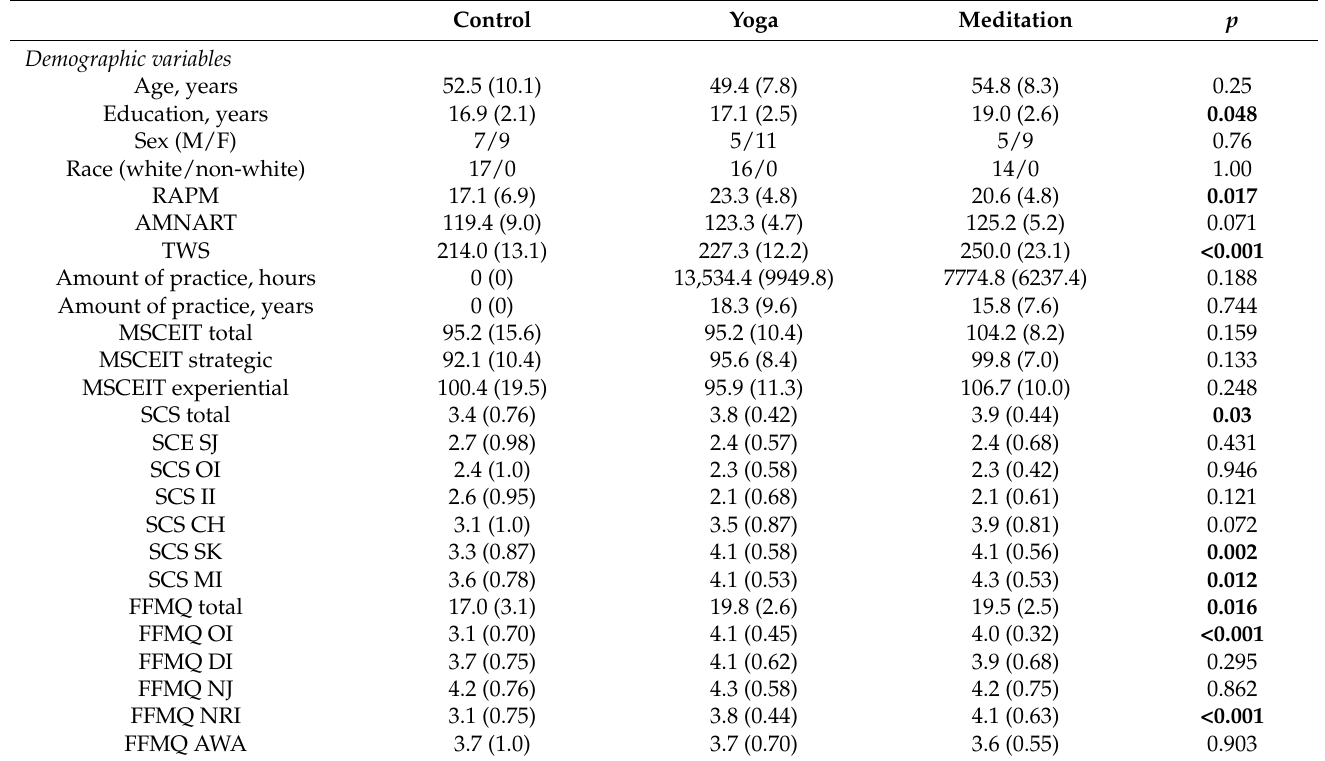
Table 1. Demographics and variables.